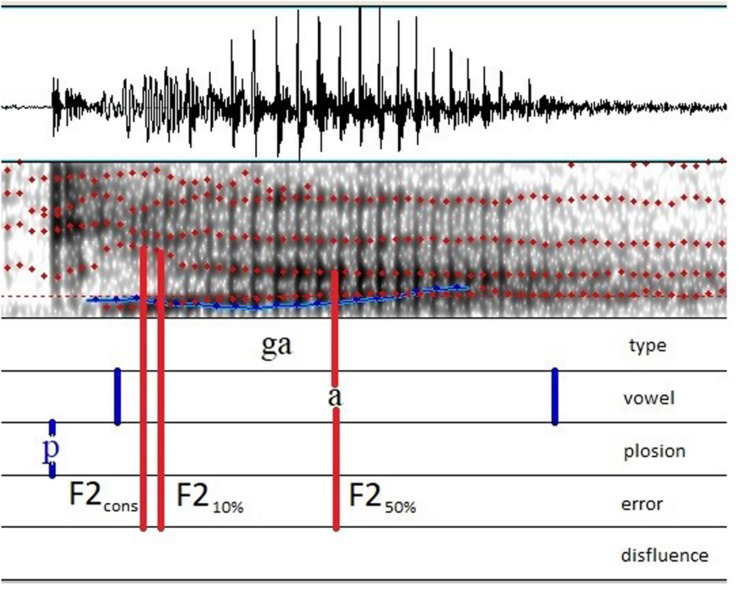
Example of three measurements taken on F2: at vowel onset (F2cons), at 10% (F210%), and at 50% (F250%) of the duration of the vowel.